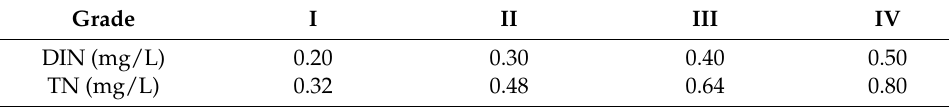
Table 2. Seawater quality standard for DIN and